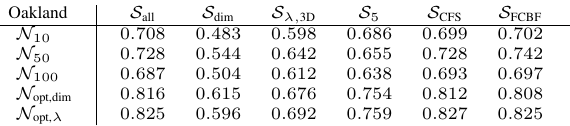
Table 9: Mean class recall values for RF-based classification us- ing different neighborhood definitions and different feature sets.